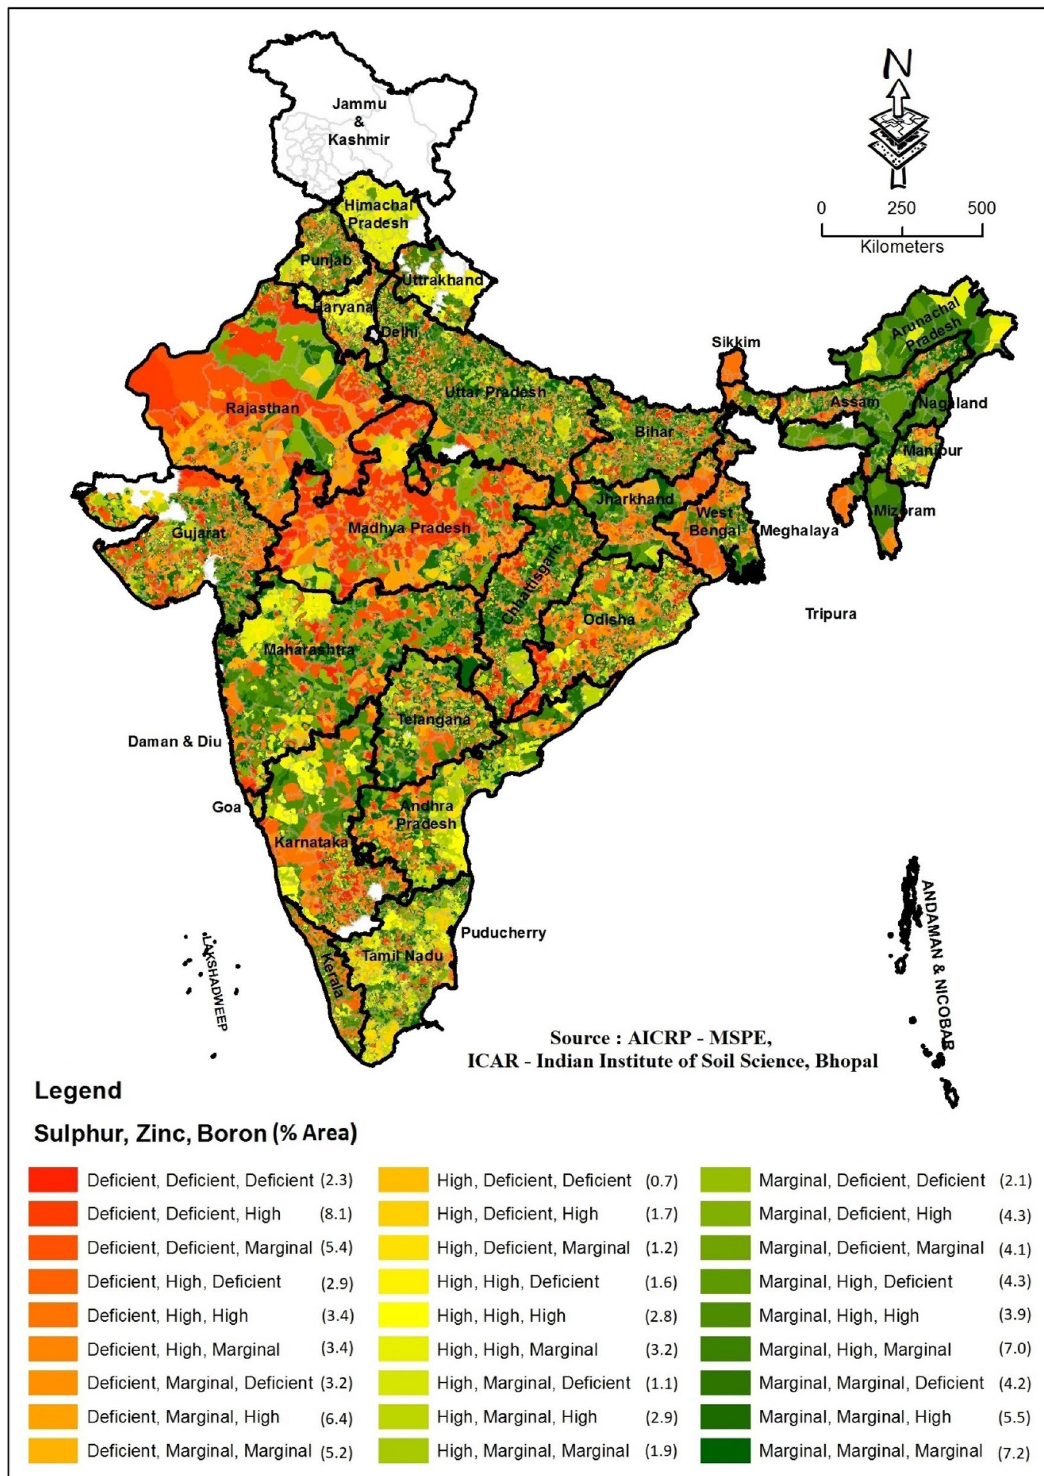
Figure 2. Spatial distribution of S + Zn + B deficiency in different states of India (The figure has been prepared using ArcGIS software (version 10.5.1), Environmental Systems Research Institute, Redlands,